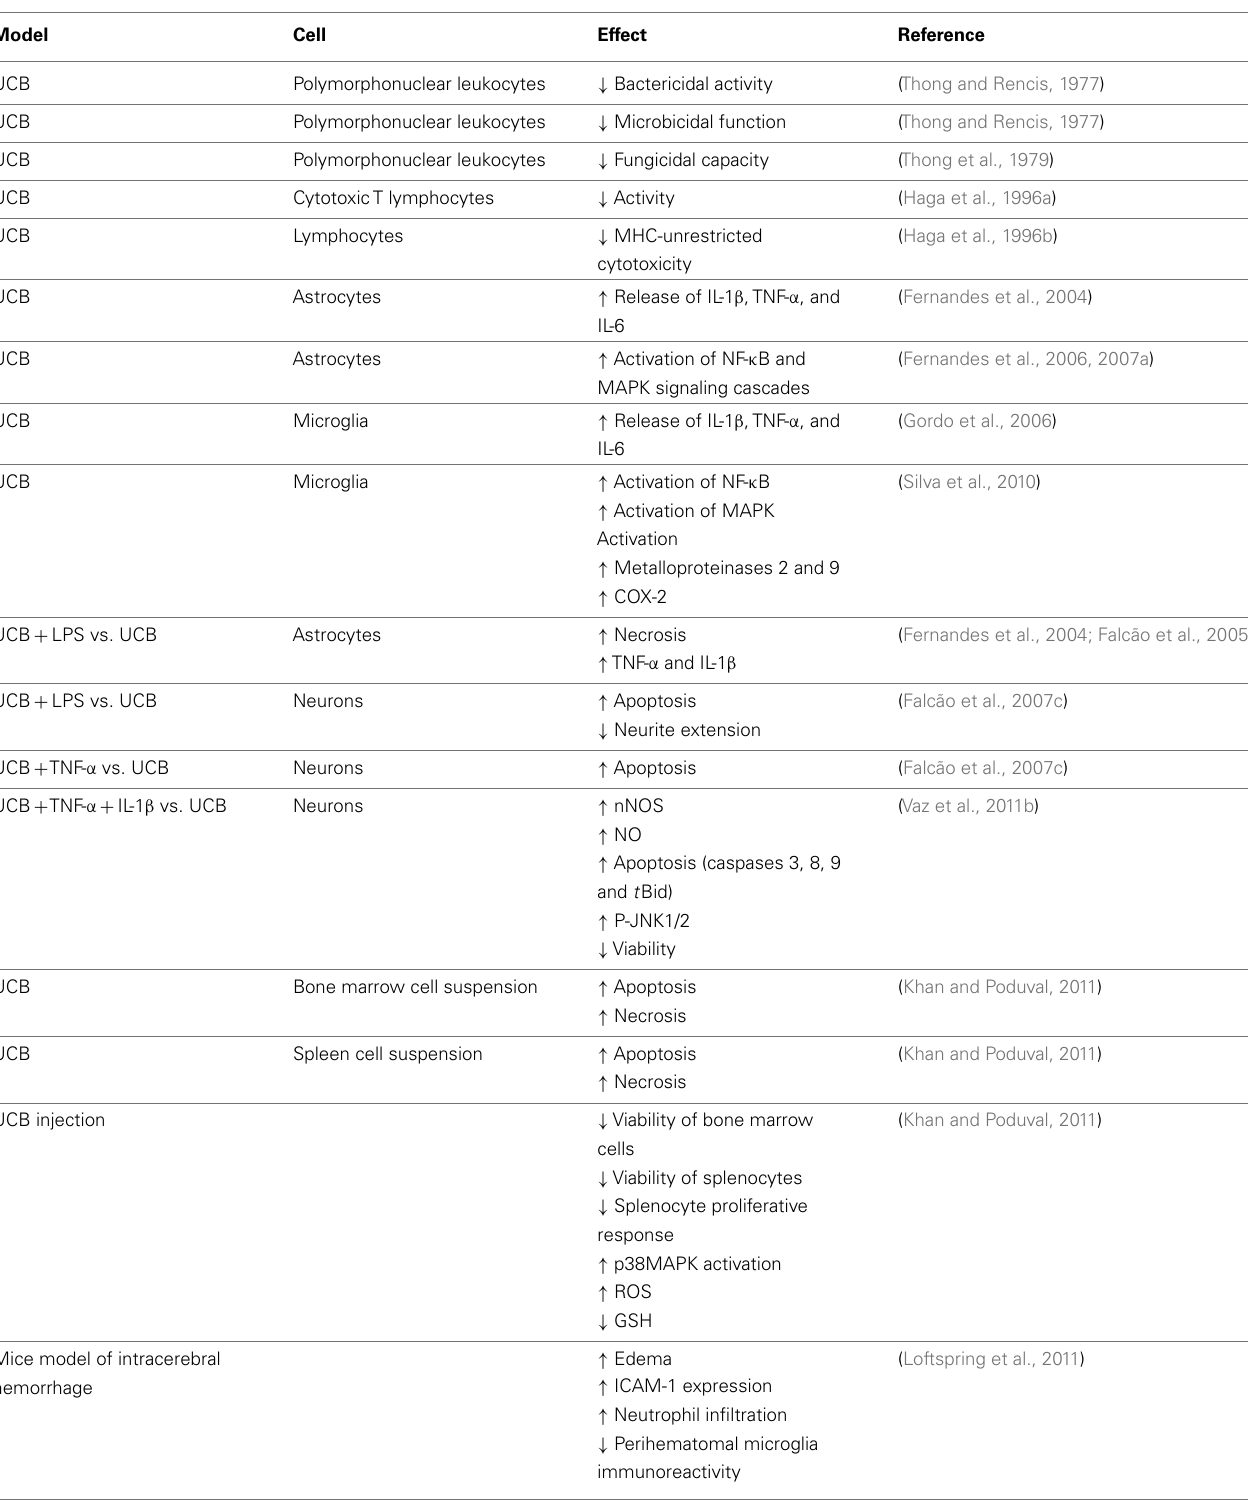
Table 1 | Immunostimulant and immunotoxic effects of unconjugated bilirubin (UCB) in cell primary cultures, cell suspensions, and animal